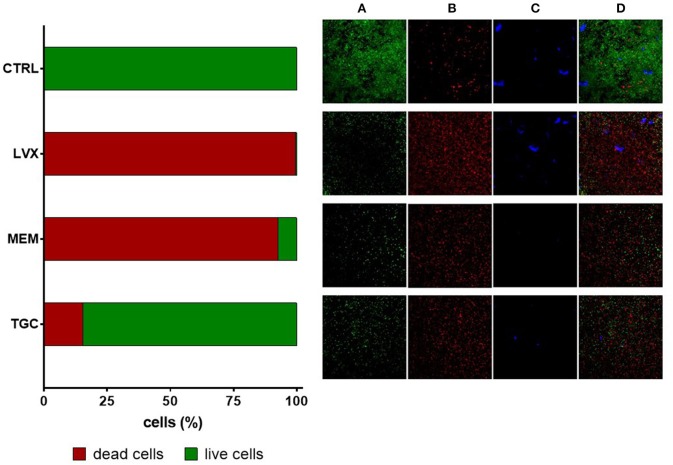
Confocal laser microscopy observation of preformed Myroides odoratimimus biofilm exposed to antibiotics at bactericidal concentration. Biofilm formed in collagen gel matrix (in SWF, pH 7.2, glucose 12.5 mM) for 7 days were exposed for further 24 h to levofloxacin (LVX), meropenem (MEM), and tigecycline (TGC) at 512 μg/ml. Control (CTRL) samples were exposed to SWF only. To the left: biofilm's viability was evaluated by viable cell count and expressed as percentage compared to CTRL samples. The proportion of dead cells is shown in red, whereas that of live cells in green. To the right: biofilms were stained with BacLight Live/Dead kit: (A) green fluorescence (live cells); (B) red fluorescence (dead cells); and (C) blue fluorescence (extracellular polymeric substance). (D) Co-localization of green, red, and blue fluorescence.